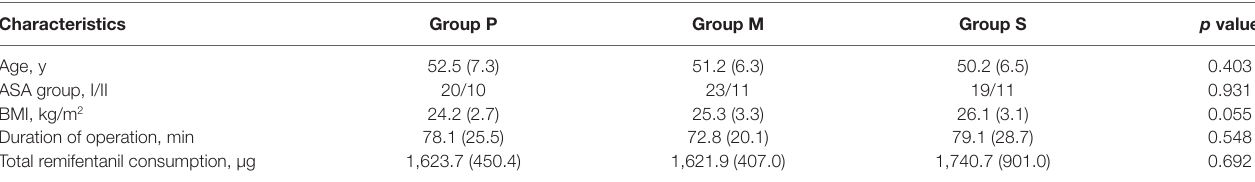
TABLE 1 | Patients’ demographic characteristic and surgical